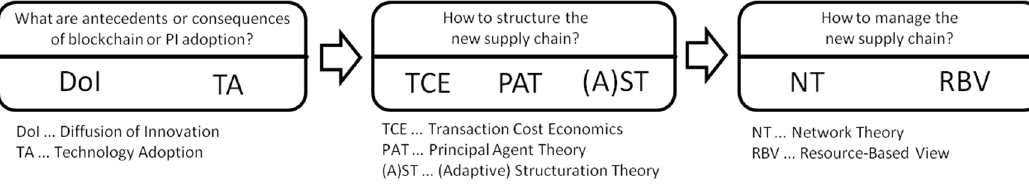
Figure 3. Theoretical perspectives and emerging research areas.